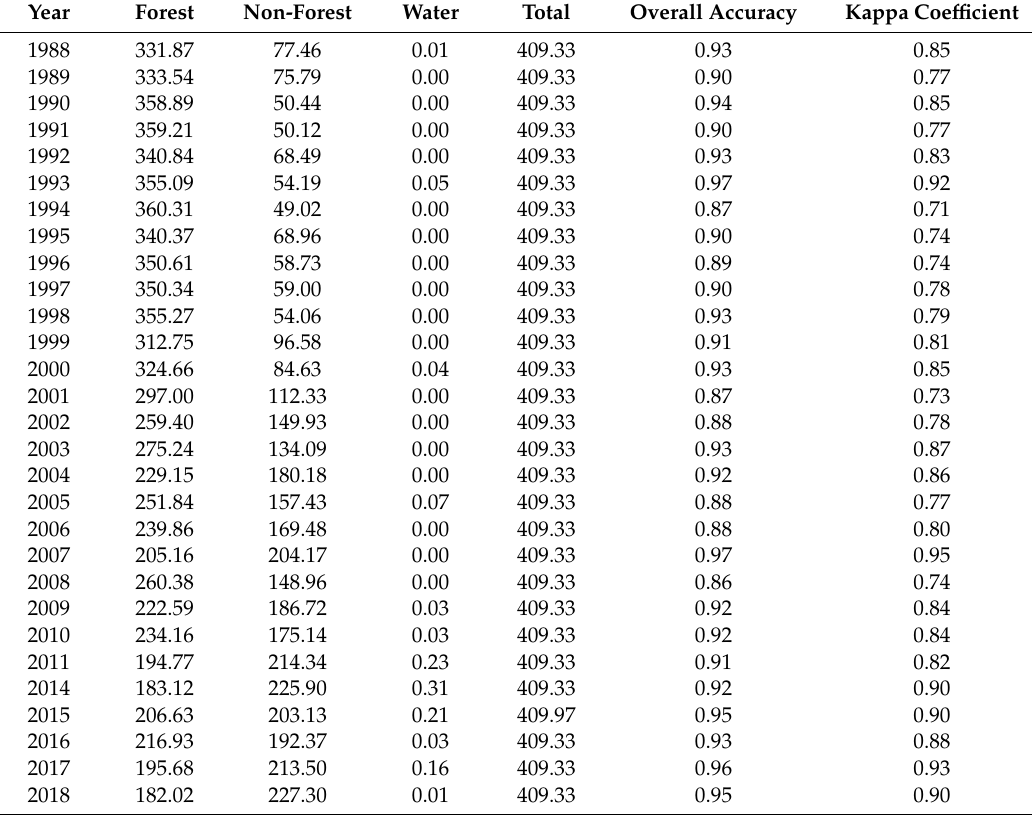
Table 4. Results from LULC classification over the last three